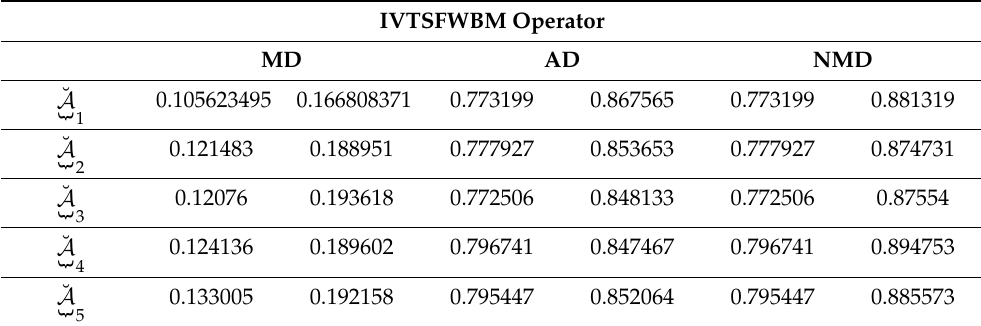
Table 5. Aggregated matrix by using the information in Table